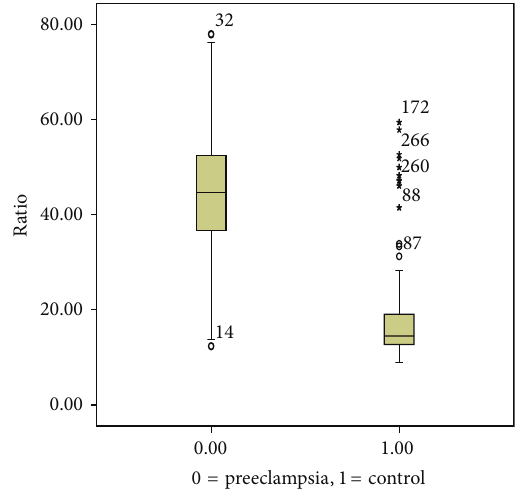
Figure3: Median and interquartilerangeof sFlt-1/PlGFratio incase group, 44.8 (16.2) and in control group, 14.4 (6.4); 𝑃 < 0.0001 .